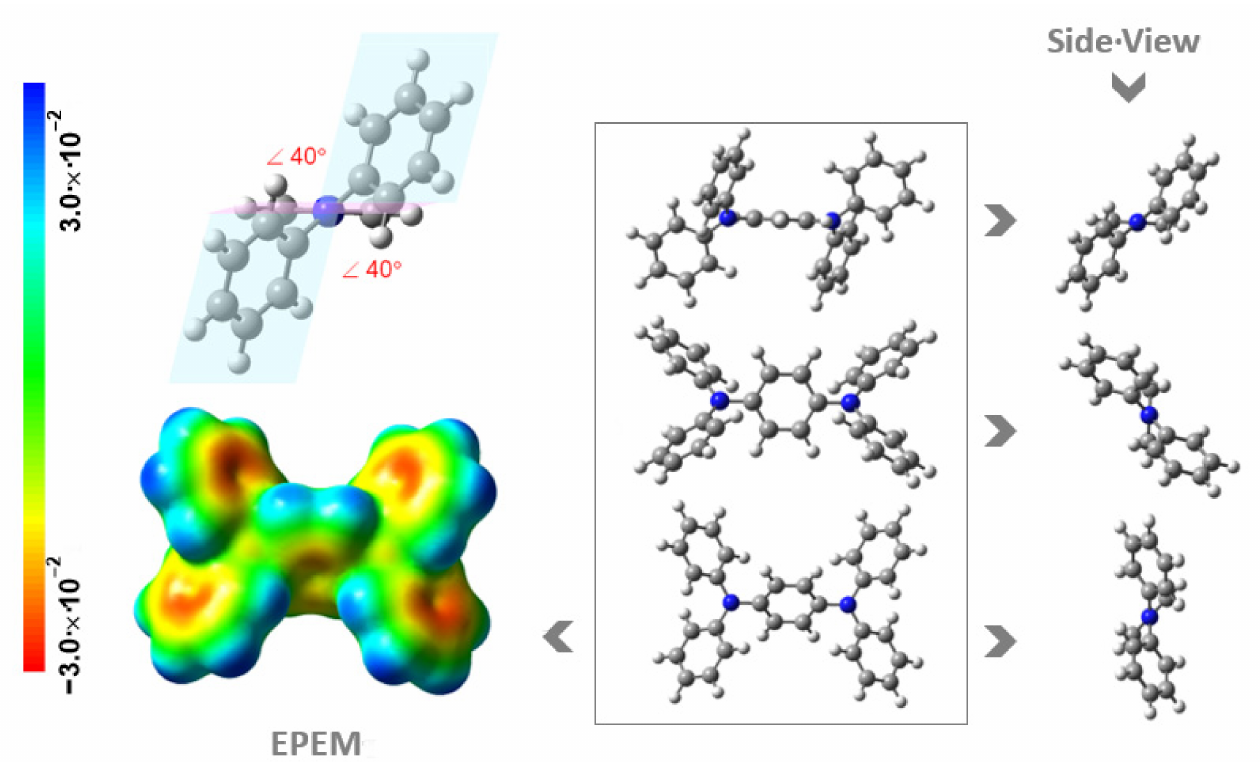
Figure 4. Different views of molecular structures and the electrostatic potential energy maps (EPEM) mapped onto the surface of the molecule, with an isodensity surface value of 0.002 e · a 0 − 3 (where a 0 is the Bohr radius; 1 e corresponds to 1.6021766208 × 10 − 19 C [20]; 1 a 0 corresponds to 5.2917721067 × 10 − 11 m [21]), calculated for DAB. The dihedral angle (in red) was calculated based on planes defined by each benzene ring and the benzene rings of the diphenyl amine moiety. Colour code for spheres: grey, C; blue, N; white,